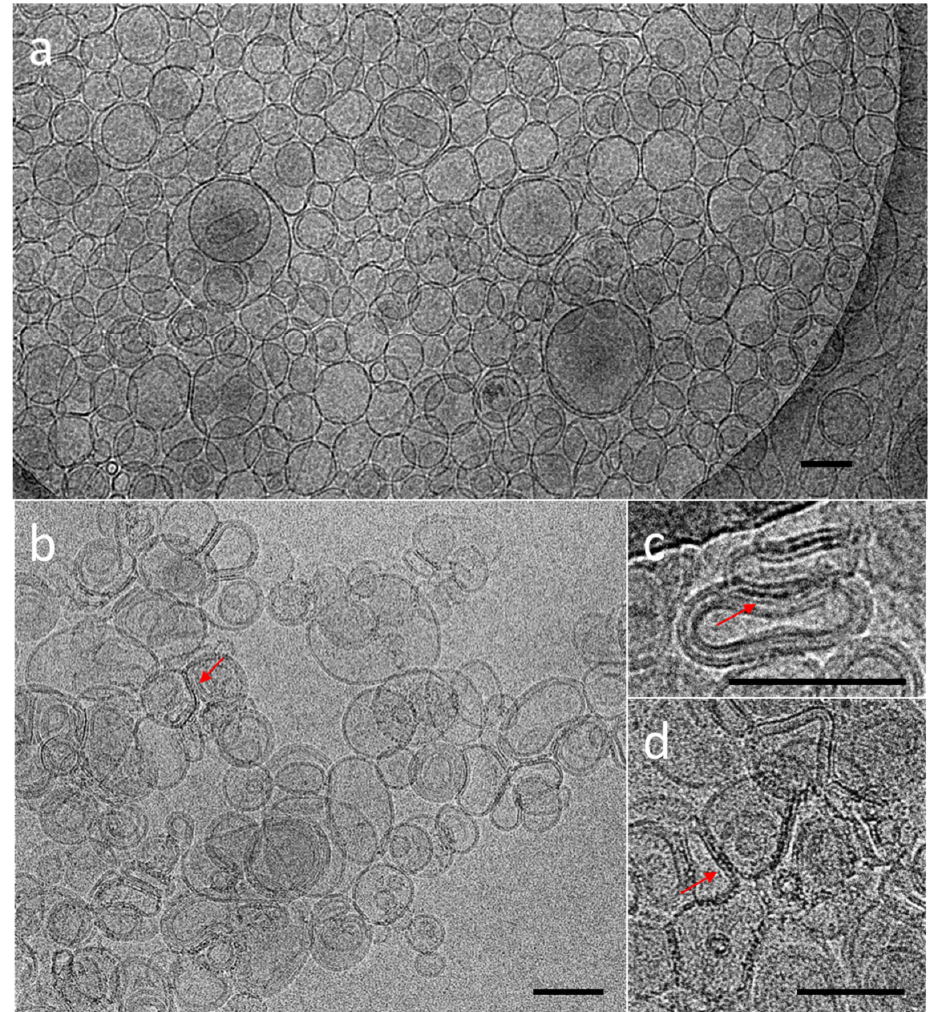
Figure 6. CryoTEM micrographs of DOPC LUVs ( a ) without NCs, ( b – d ) in the presence of C 3 E 6 D Red NCs. The red narrows point out the presence of AuNCs. Scale bar represents 100 nm.